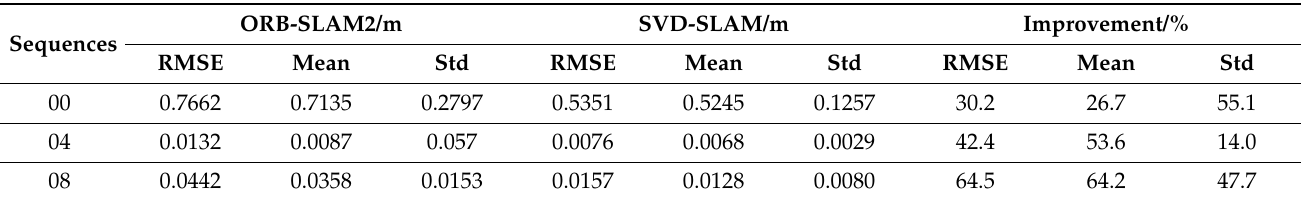
Table 3. Comparison of absolute trajectory error (ATE).